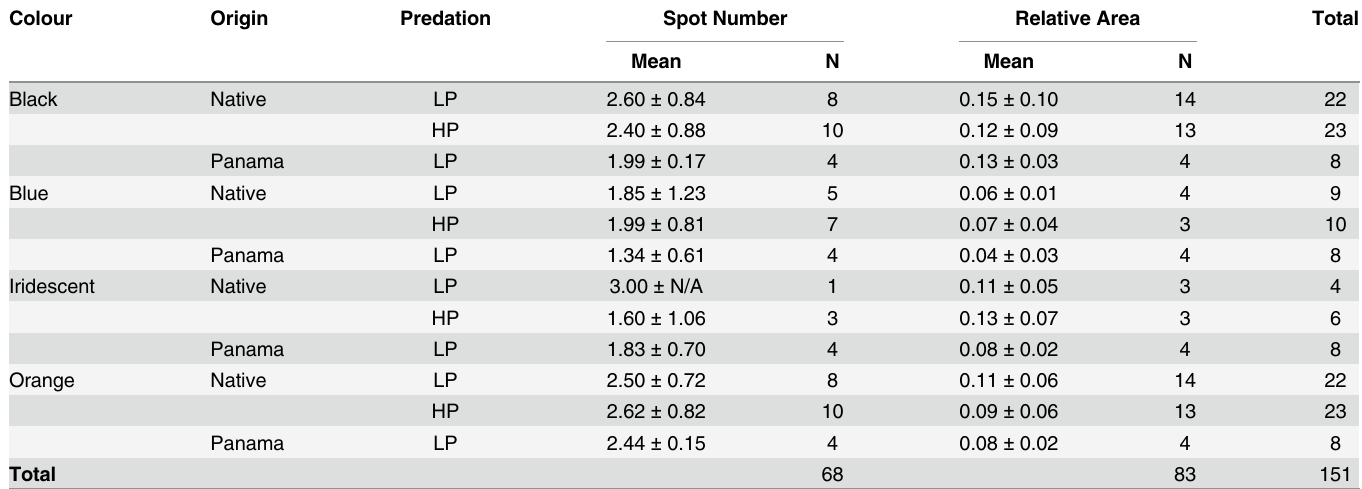
Table 2. Colour patterns in populations of Poecilia reticulata from native low- and introduced low- and high predation environments. The data rep- resent the mean ± standard deviation (SD) of the number and the relative area of the most commonly reported colour spots in the literature and in the present study. N represents the number of estimates of colour parameters at population level obtained from the literature (Native) and from this study (Panama) at both low (LP) and high (HP) predation regimes. Total refers to the total number of populations across environments and colour parameters. The complete list of values and authors of each study can be found in S2